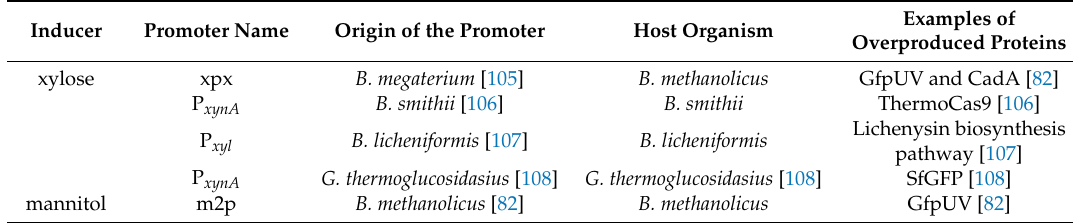
Table 3. Inducible promoters used in thermophilic